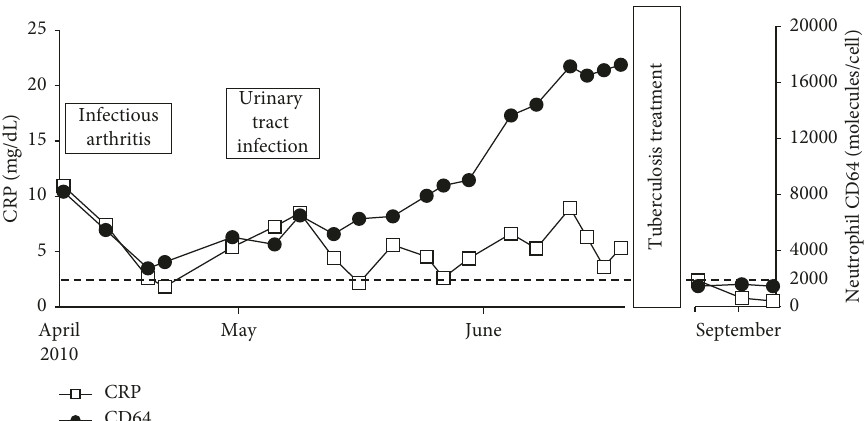
Figure 1: Levels of neutrophil CD64 elevated with dissociation of a CRP change (case 1). The cutoff value for the levels of neutrophil CD64 was 2000 molecules/cell.